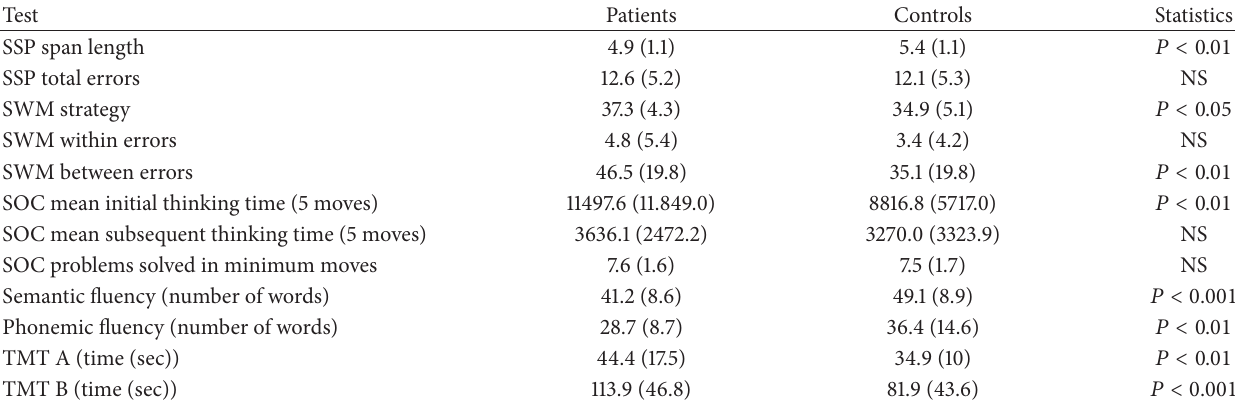
Table 2: Group differences in cognitive performance (values expressed as means and standard deviations shown in brackets).